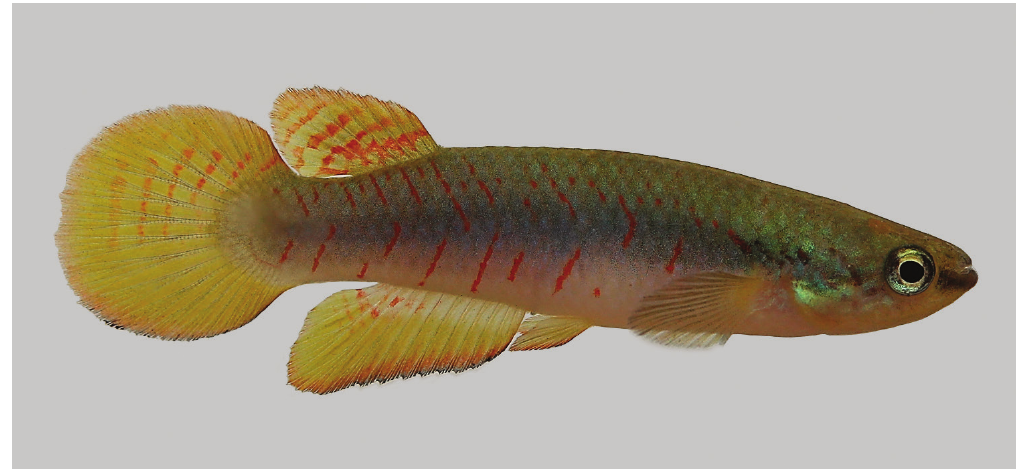
Figure 1. Melanorivulus interruptus sp. n., MCP 53145, holotype, male, 32.3 mm SL, Campo Grande, Mato Grosso do Sul, Brazil.